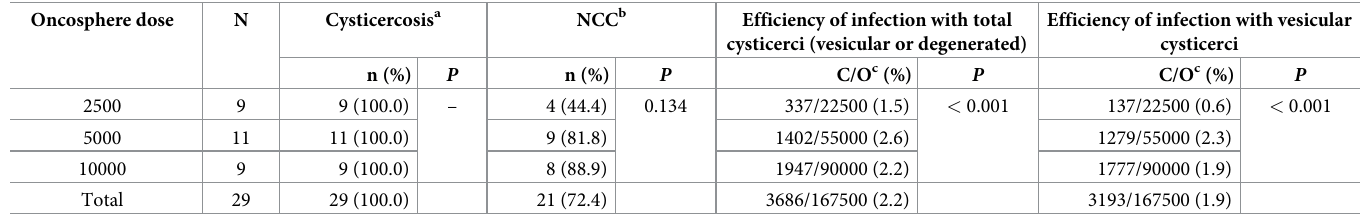
111 cysticerci [IQR: 54–141] for 5000 oncospheres, and median: 190 cysticerci [IQR: 136–233] for 10000 oncospheres, compared to median: 6 cysticerci [IQR: 2–18] for 2500 oncospheres, Table 1. Distribution of pigs with cysticercosis and NCC, as well as efficiency of infection (%) according to oncosphere dose–groups. Oncosphere